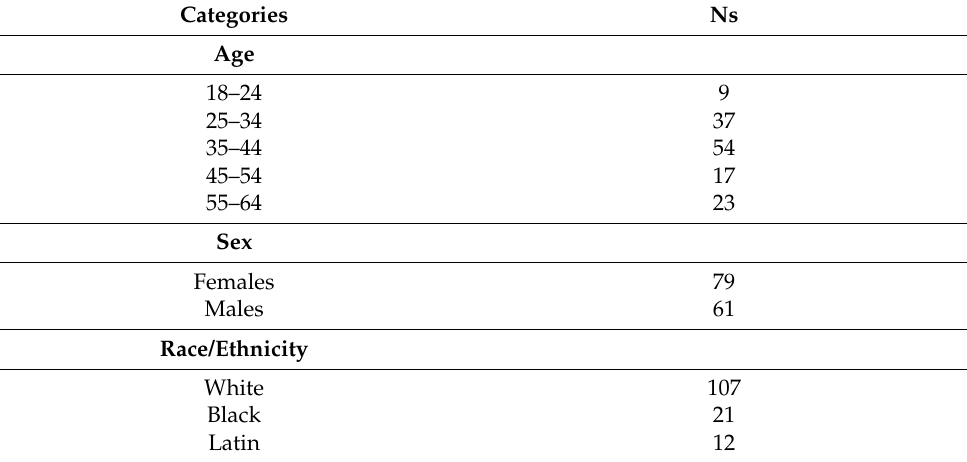
Table 1. Demographic characteristics of the participants included in Study 1 (N =